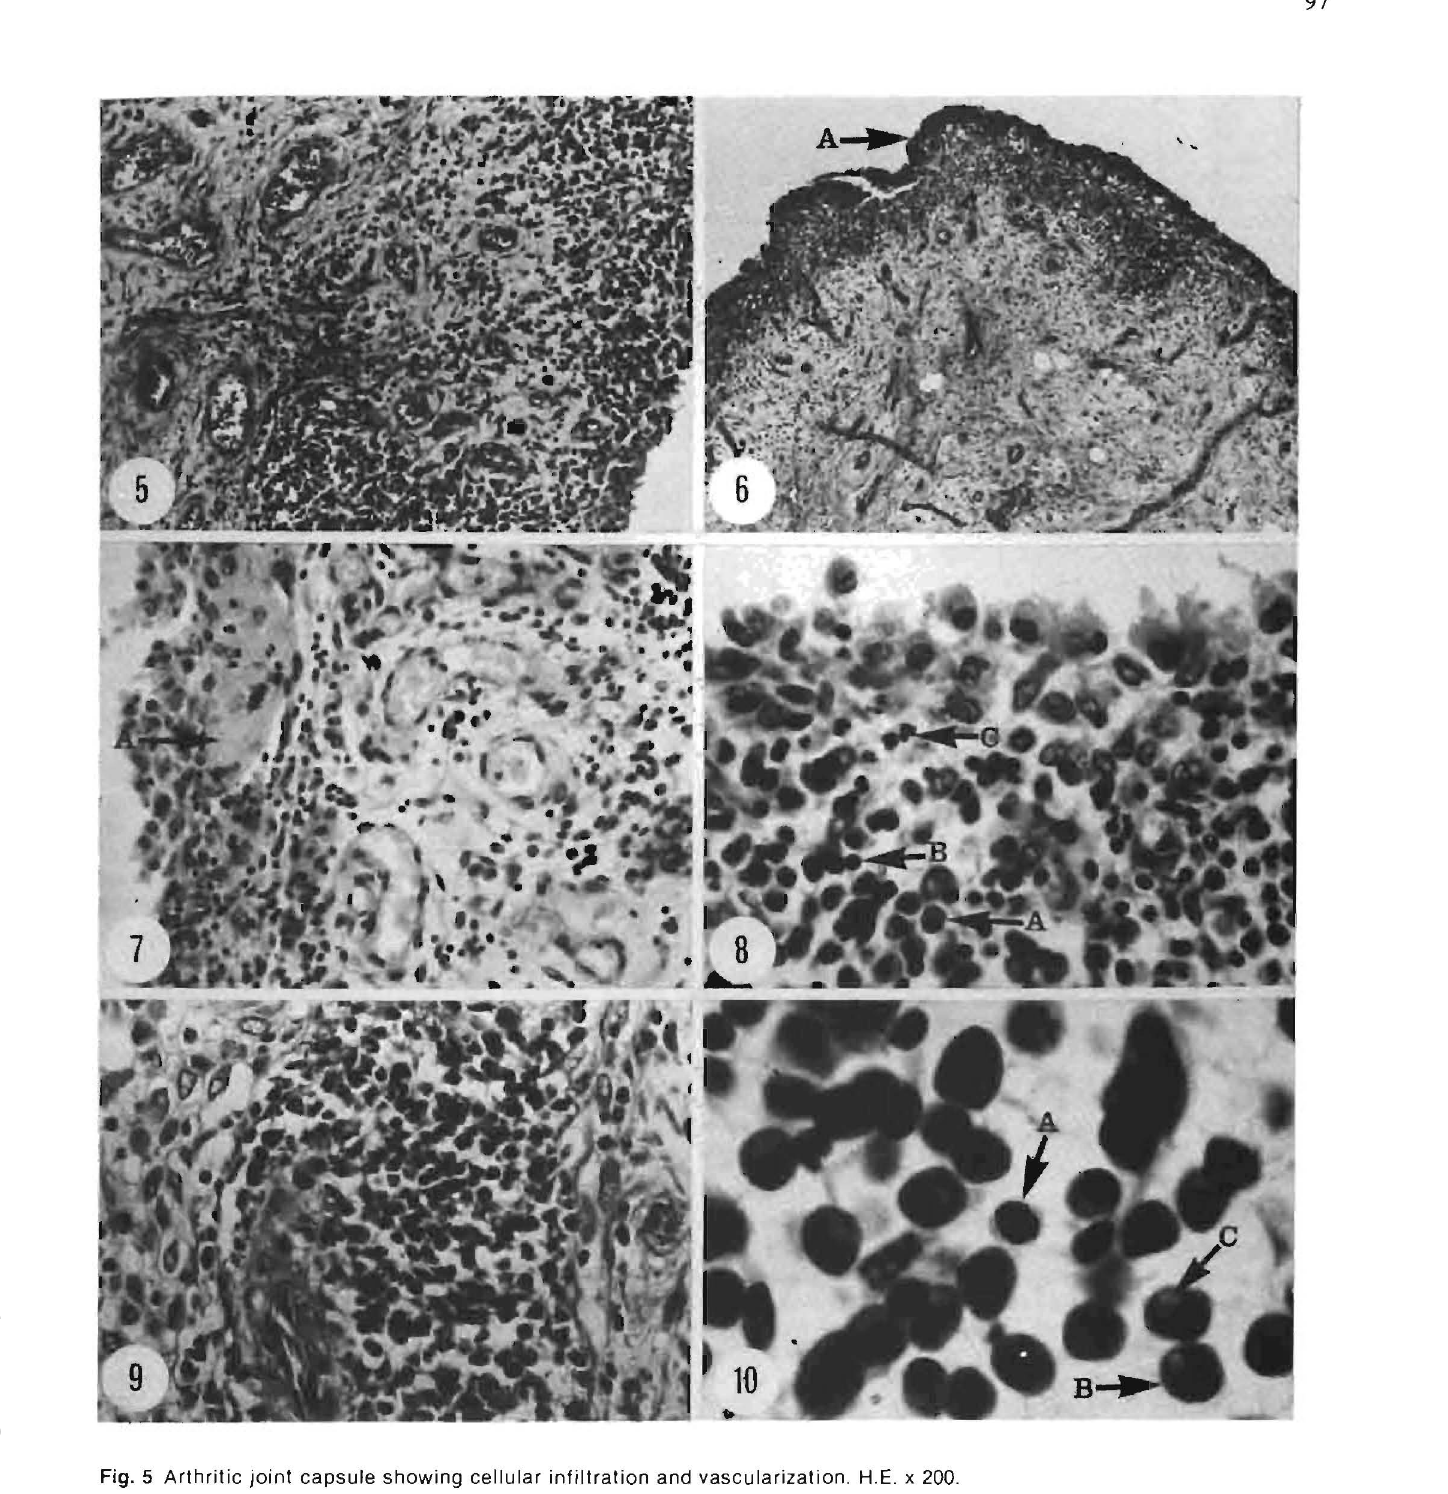
Fig. 5 Arthritic joint capsule showing cellular infiltration and vascularization. H.E. x 200. Fig. 6 Tip of hypertropic villus with fibrin on surface (A), sub·synovial cellular infiltration and vascularization. H.E. x 75. Fig.7 Arthritic jOint capsule with fibrin (A) in disrupted synovial epithelium, sub-synovial cellular infiltration and vascularization. H.E. x 300. Fig.8 Hypertrophy and hyperplasia of synovial epithelium with subsynovial infiltration of plasma cells (A), lymphocytes (8), and neutrophils (C). H.E. x 600. Fig. 9 Focal lymphocytic and plasma cell infiltration in arthritic joint capsule. H.E. x 500. Fig.10 Lymphocytic (A) and plasma cell (B) infiltration. Some plasma cells have small Russel bodies in the cytoplasm (C). H.E. x